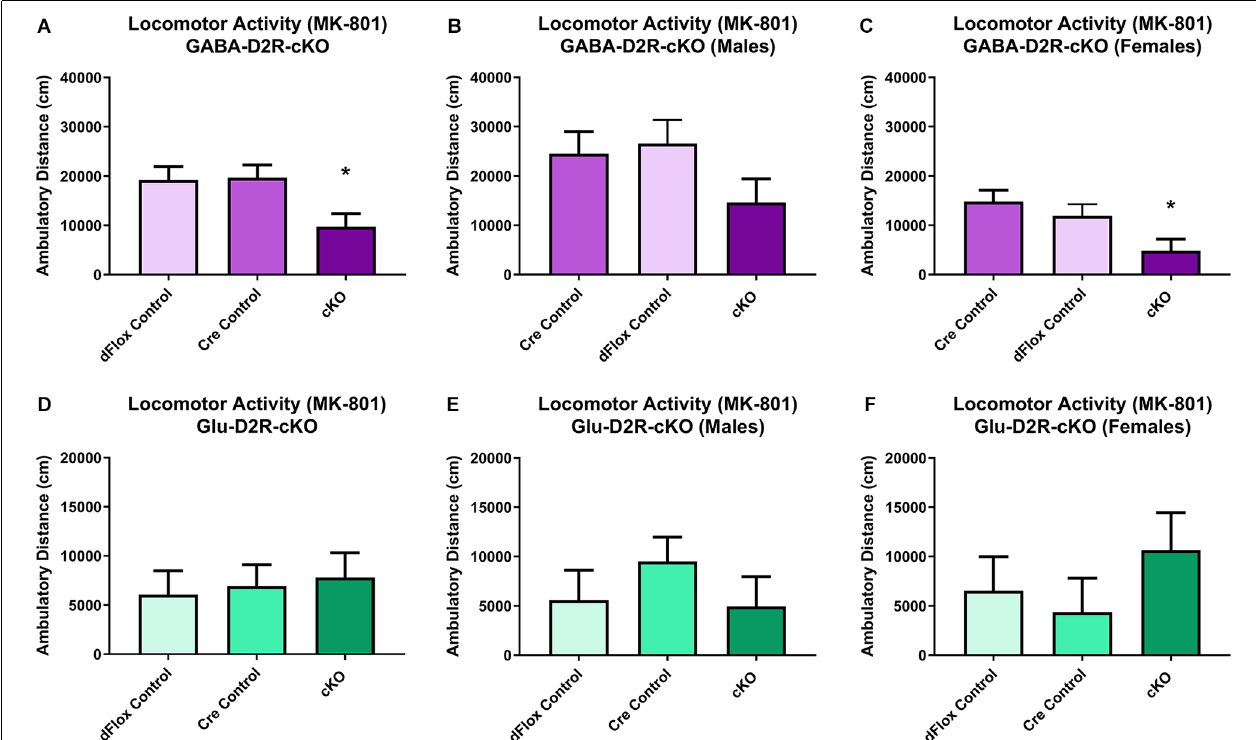
FIGURE 5 | Changes in MK-801-induced locomotor activity in GABA-D2R-cKO mice. Cumulative activity following MK-801 administration in the GABAergic (A–C) and glutamatergic (D–F) D2R-cKO lines, with significant genotype ( p < 0.05, Cre, dFlox > KO) and sex ( p < 0.001) differences only in the GABA-D2R-cKO mice. Data show total activity with males and females combined (A,D) and separately within males (B,E) and females (C,F) . N = 4–7/genotype × sex group; * p < 0.05 as compared to either control group by post hoc